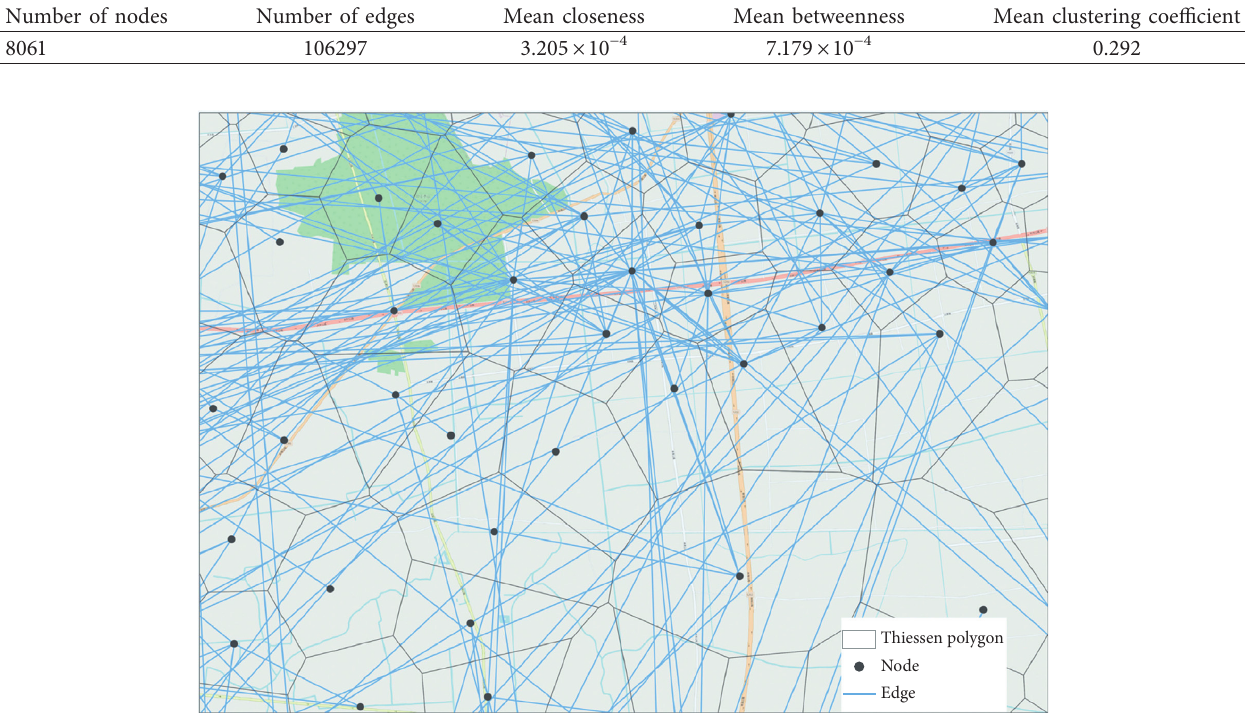
Figure 4: The sharing-bike network of Shanghai (part of the network).